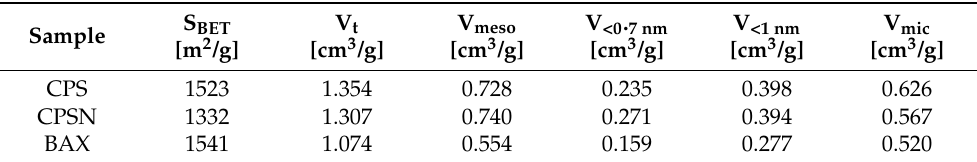
Table 2. The parameters of pores structure calculated from nitrogen adsorption isotherms. Adapted with permission from Reference [48]. Copyright 2016,